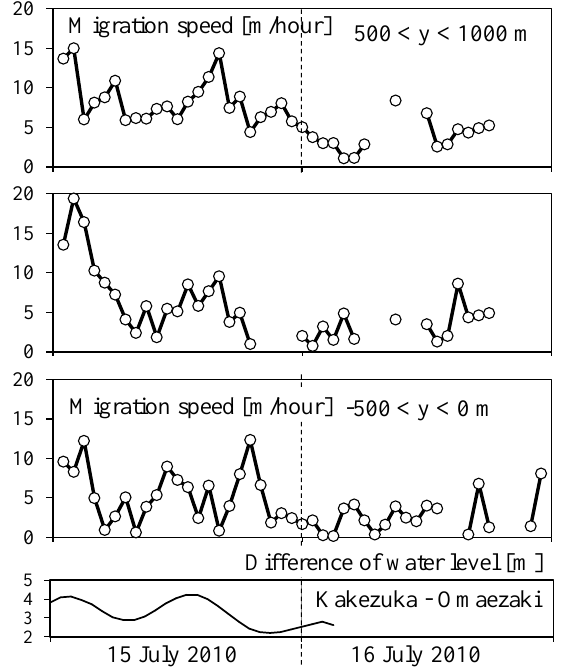
Figure 6. Variation of migration speeds of light-dark patterns in the time-averaged radar image and the water level difference between the river and the sea.